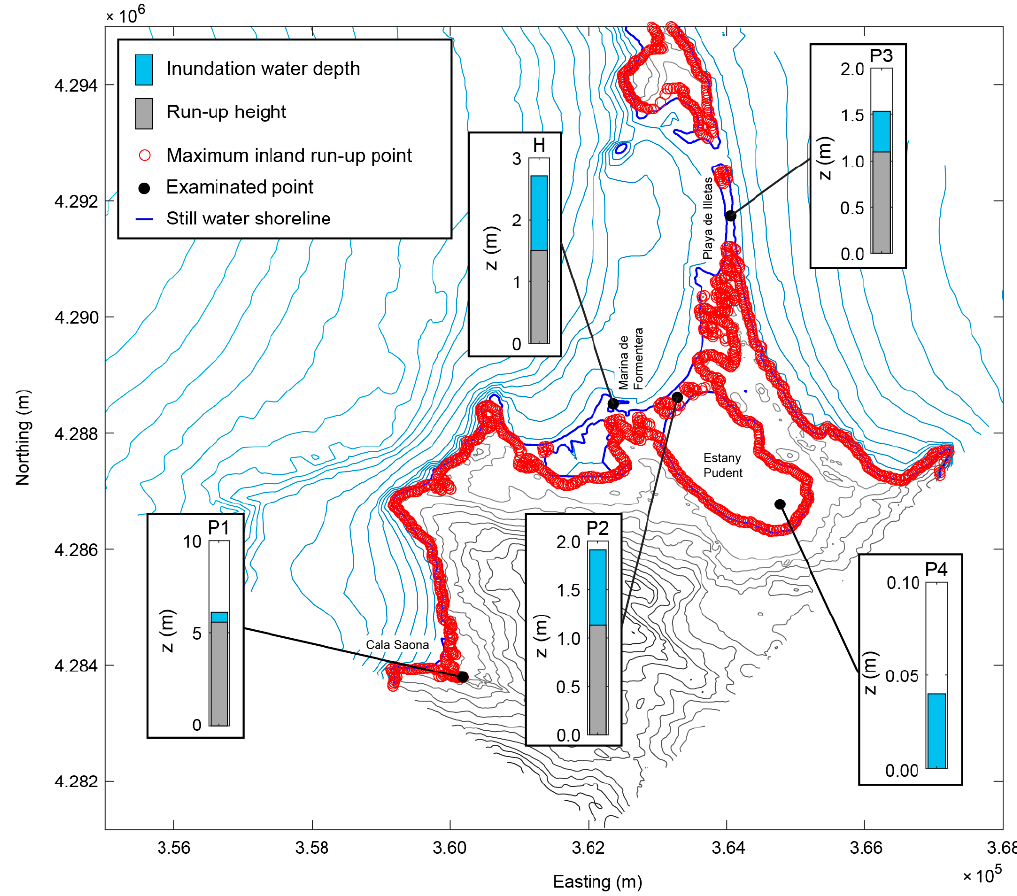
Figure 13. Maximum run-up heights and water depths at different points of interest in scenario 2.